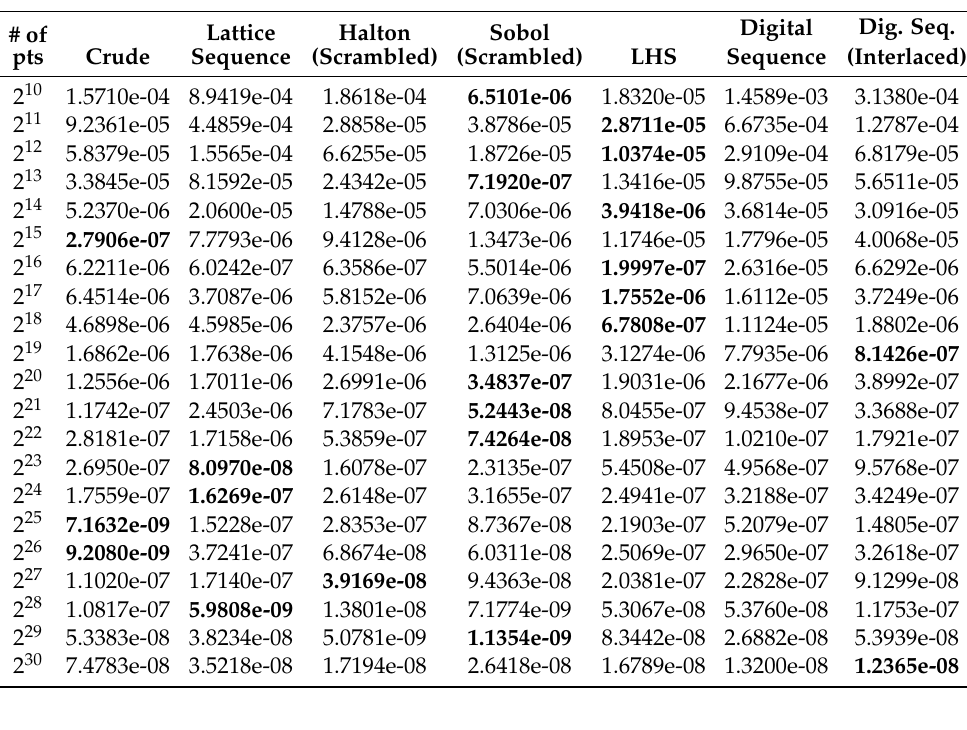
Table 6. The 60-dimensional integral absolute errors.